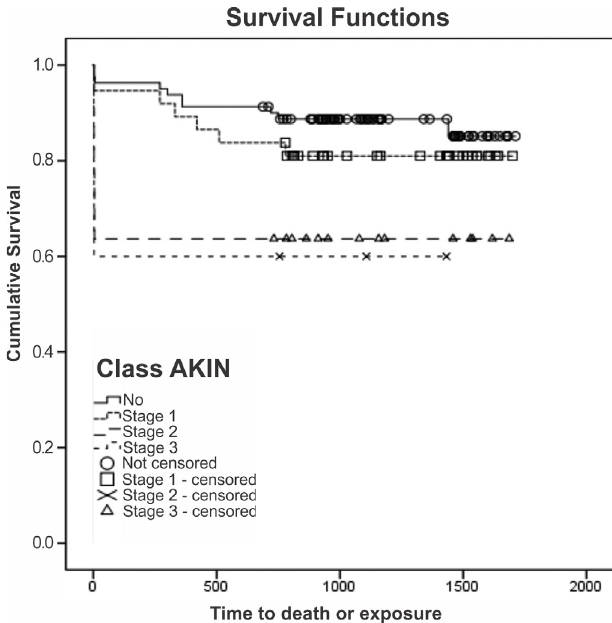
Fig. 3 - Analysis of survival according to the Acute Kidney Injury Network (AKIN) classification for acute kidney injury